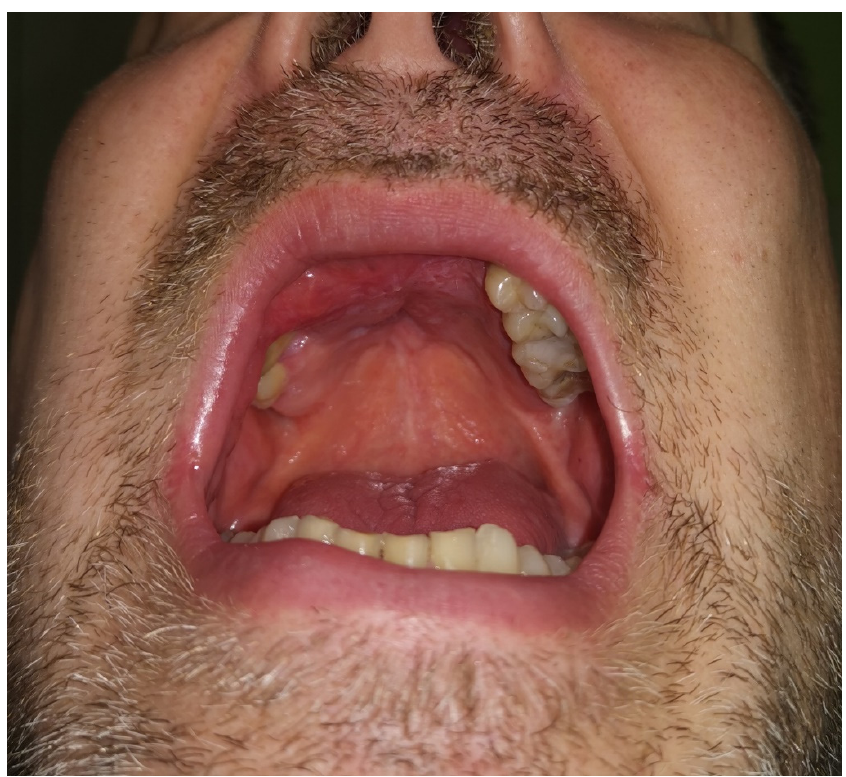
Figure 8. Postsurgical oral status after radiotherapy at 22 months after surgery. The flap is completely healed and no hair-bearing skin is present.